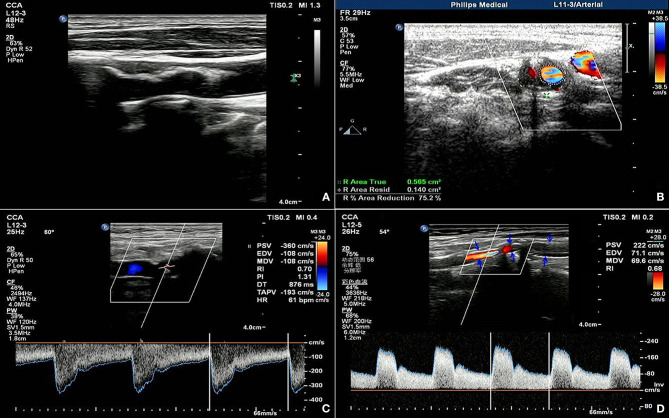
Ultrasonic manifestation before and after coronary artery stenting in patients predicted as having non-ideal outcomes. (A) shows the long axis view of the vessel before the operation, showing the strong echo mural plaques in the stenosis; (B) shows the transverse view of the stenosis, showing the area stenosis rate of 75.2%; (C,D) show the blood flow in the stenosis before the ESP and 30 days after the operation, respectively, showing the poor extension of the carotid stent after the operation, and the blood flow PV and RI in the stent are lower but still higher than before the operation.